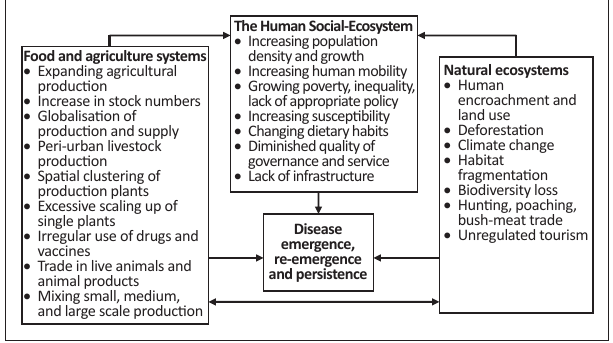
FIGURE 2: Interactions that may lead to disease